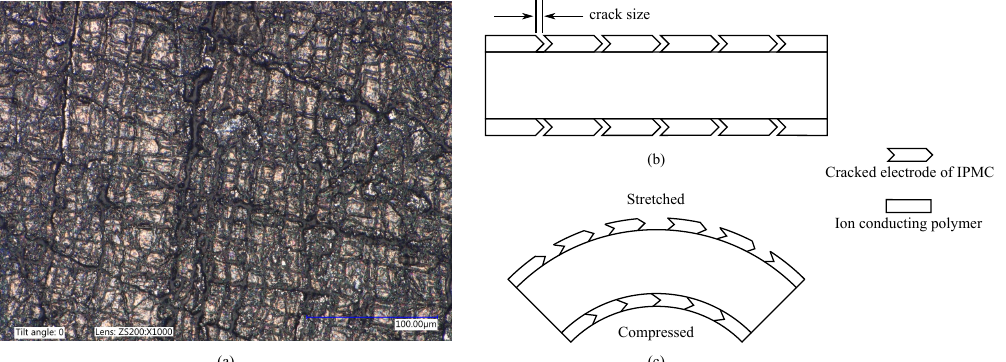
Figure 13. Cracked structure of IPMC metal electrodes. Bending varies the width of the cracks, i.e., they widen on the stretched side, and tighten on the compressed side, varying the resistance of the electrodes. ( a ) Microscopy image of an IPMC electrode. ( b ) Electrode structure at rest. ( c ) Electrode structure when bent.